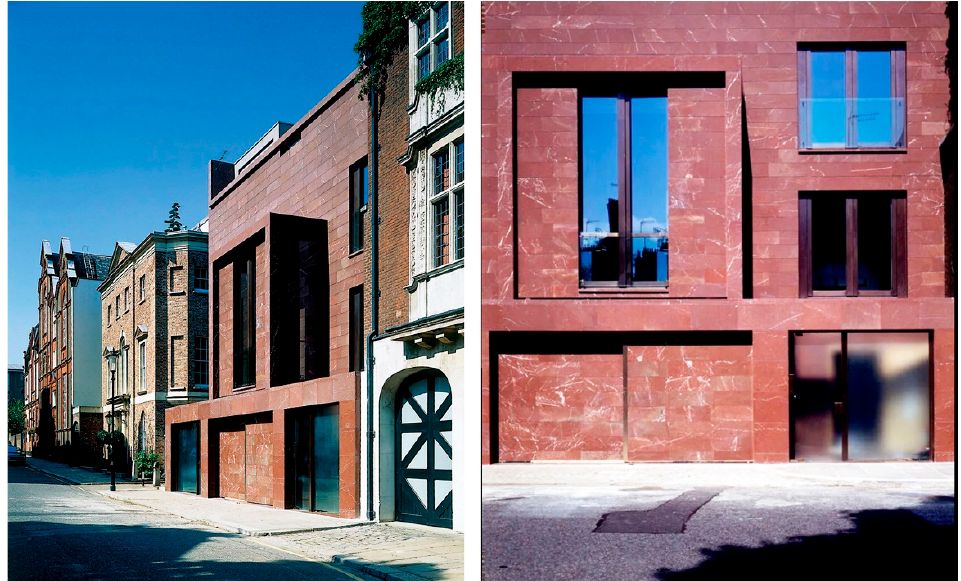
Figure 5. The Red House, Chelsea, London, 2000, Tony Fretton. © Hélène Binet.